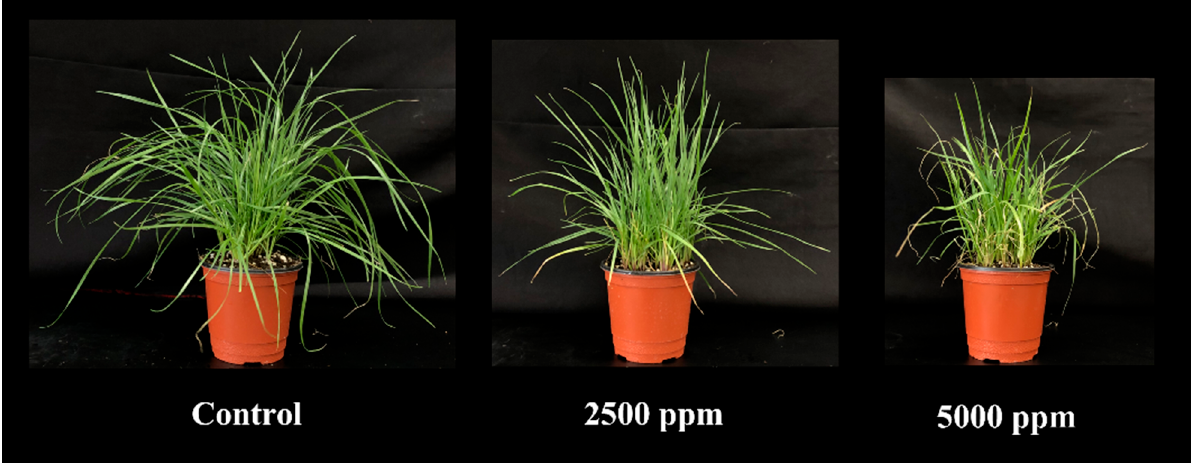
Each value represents the mean ± SD. Each data point represents the mean of at least six replicates. Different letters in the row after mean values represent the least significant differences at p ≤ 0.05.